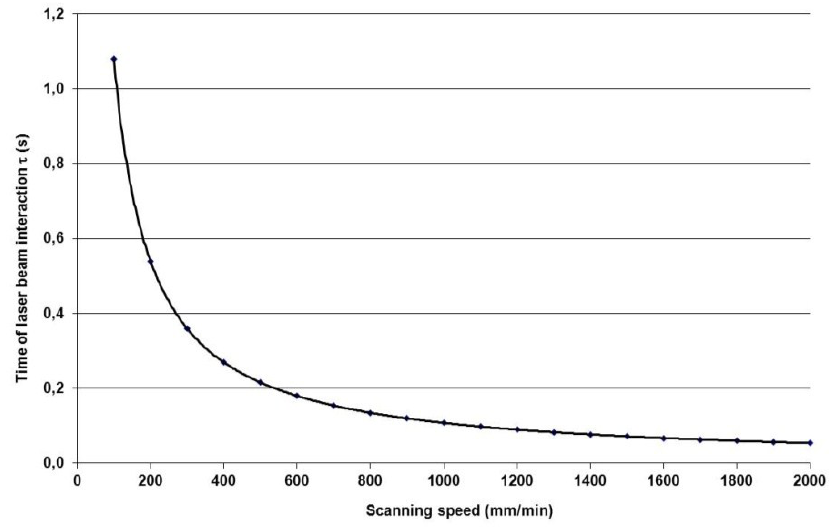
Figure 4. Relationship between the interaction time τ of laser beam and scanning speed v determined for the rectangular beam spot of a width of 1.8 mm.